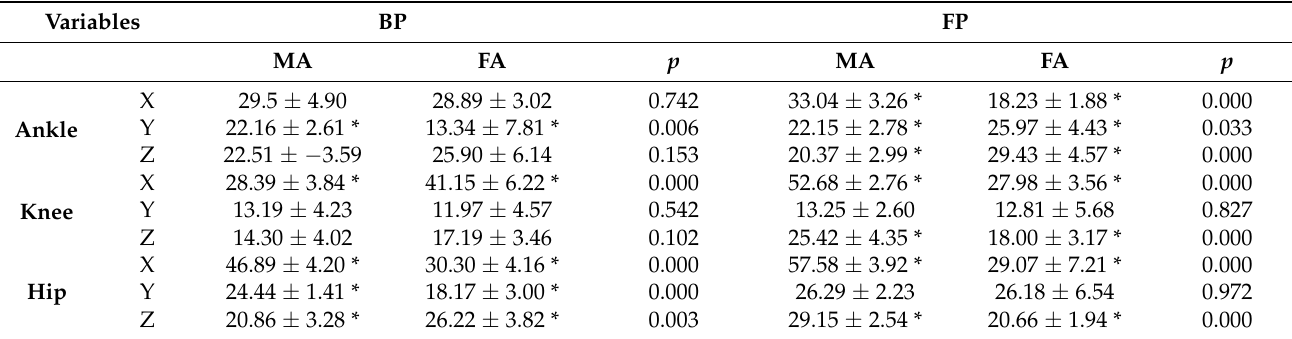
Table 4. Comparison of means ± standard deviations for ROM values in the BP and FP between MA and FA (unit: degrees).